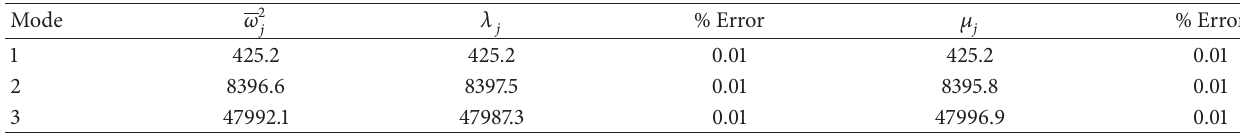
Table 4: Optimal frequencies and MRQA (Case 1).